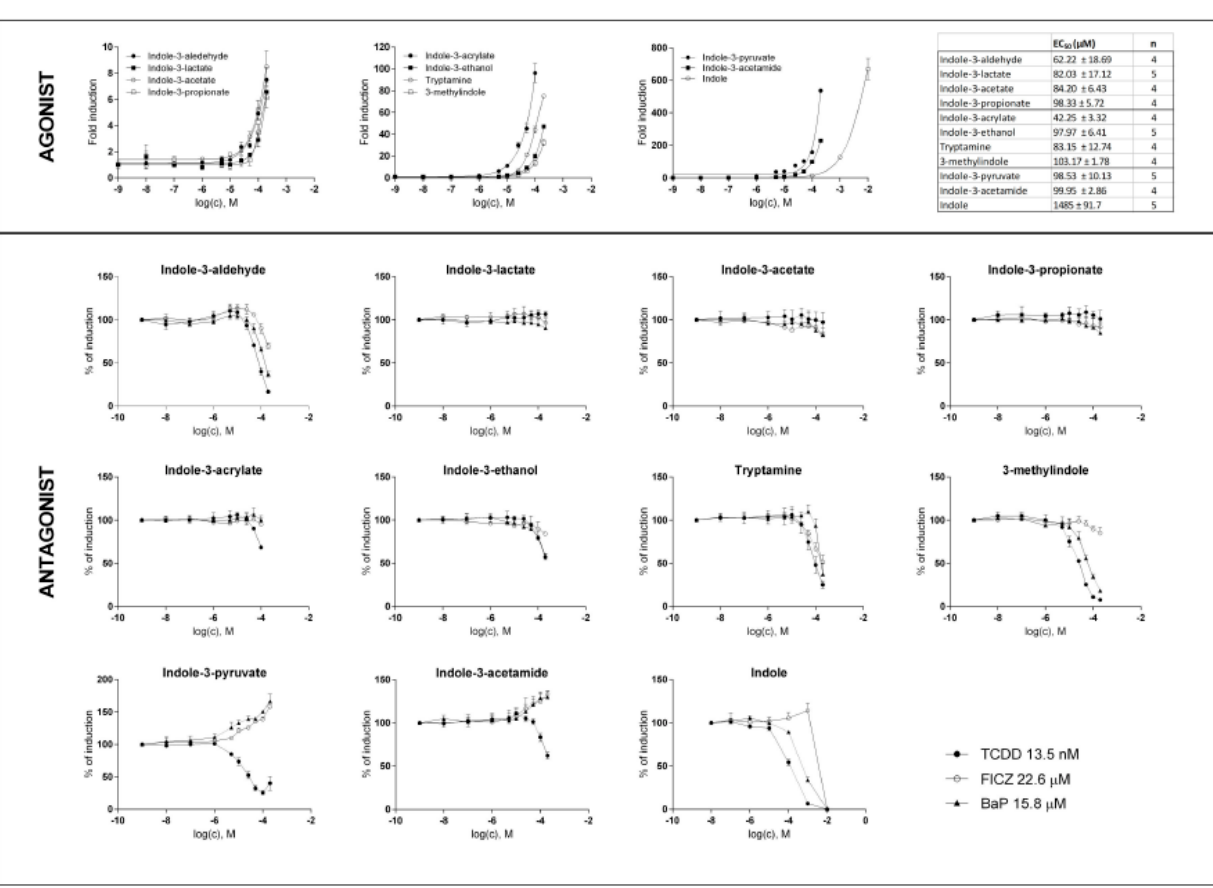
Figure 1. E ff ects of MICT on the AhR transcriptional activity in the reporter gene assay. AZ-AHR cells were incubated for 24 h with vehicle (DMSO; 0.1% v / v) and increasing concentrations of MICT, in the absence (agonist analyses) or the presence (antagonist analyses) of TCDD (13.5 nM), BaP (15.8 µ M) and FICZ (22.6 µ M). Following the treatments, we lysed cells, and luciferase activity was measured. Experiments were performed at least in four consecutive cell passages. Incubations were performed in quadruplicates (technical replicates). In agonist analyses, the data from a representative experiment, expressed as a fold induction of luciferase activity over control cells, are shown. In antagonist analyses, the data are a percentage of maximal induction, and they are the mean ± SD. The inserted table shows the number of cell passages and calculated EC 50 for each test